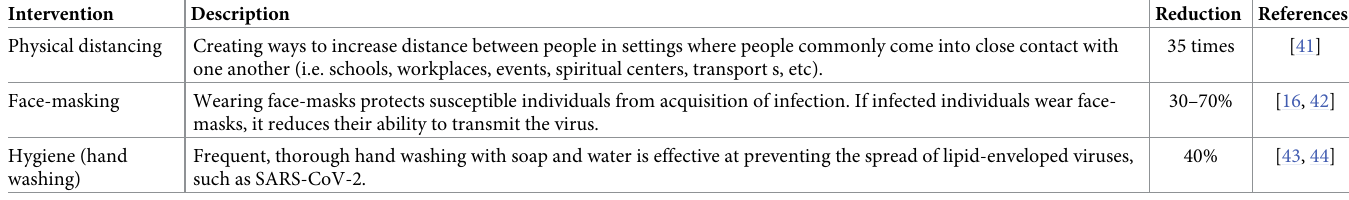
Table 3. Summary of considered intervention mechanisms and their effect on reducing the spread of COVID-19 based on existing literature. Intervention